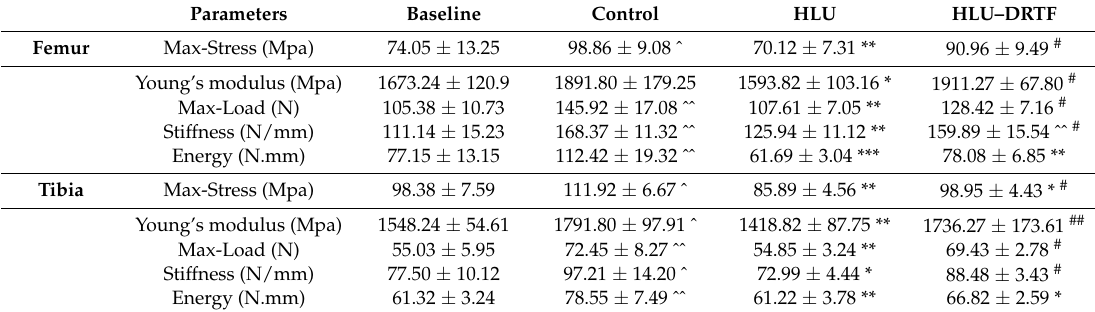
Table 2. Effects of DRTF treatment on bone biomechanical parameters in rat femoral and tibial